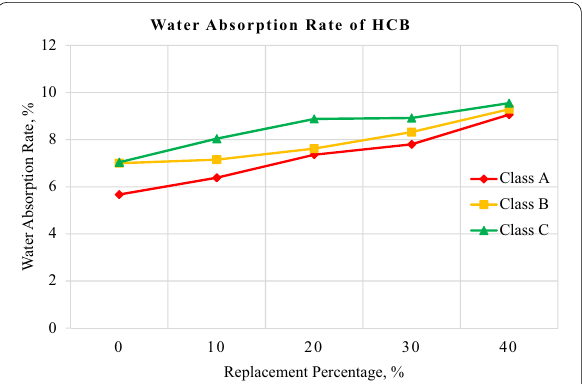
Fig. 5 Graphical representation of crusher dust effect on water absorption of